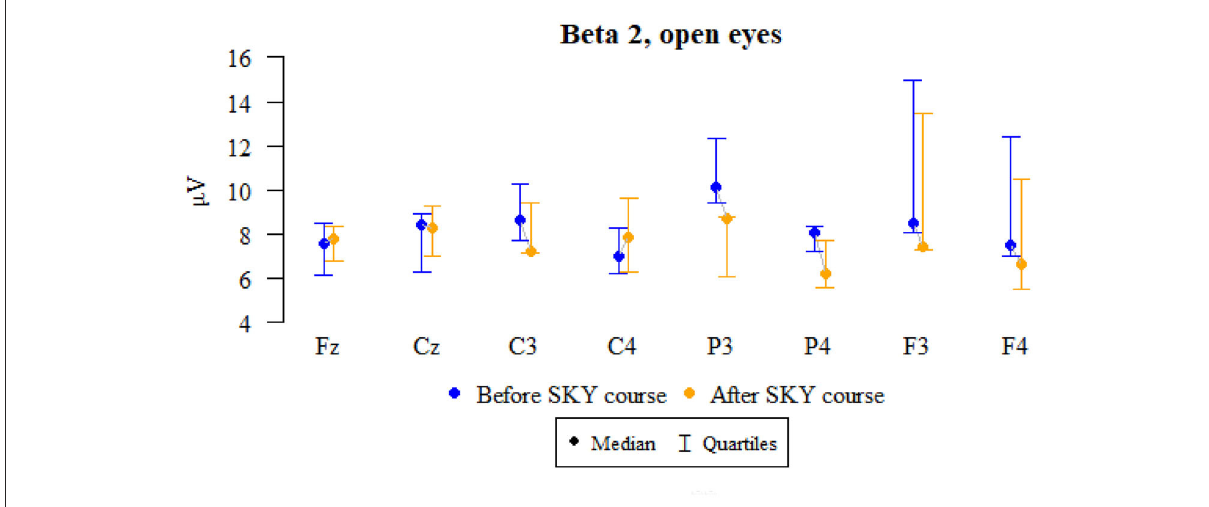
FIGURE5 Graphical comparison of Beta 2 wave amplitudes before the SKY course (first day) and after the whole SKY course (third day) with eyes open.